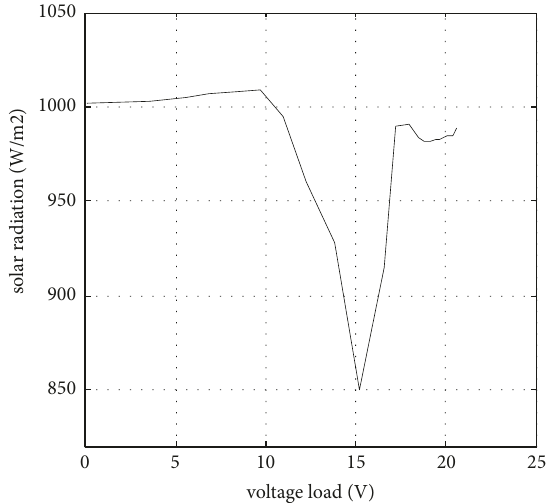
Figure 12: Variation of solar radiation with the load voltage.